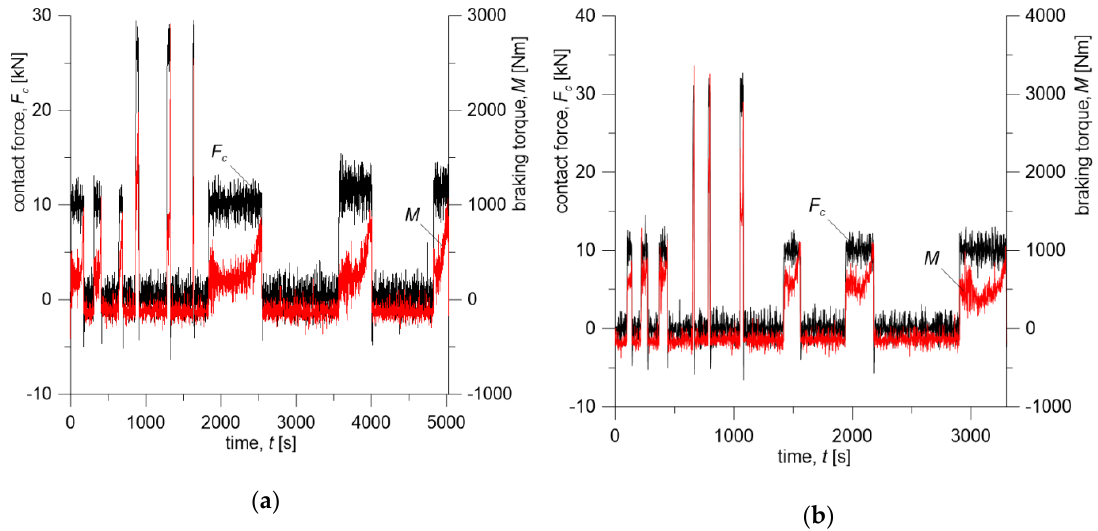
Figure 3. Changes in contact force F c and braking torque M during braking for: ( a ) Material A; ( b ) Material B.